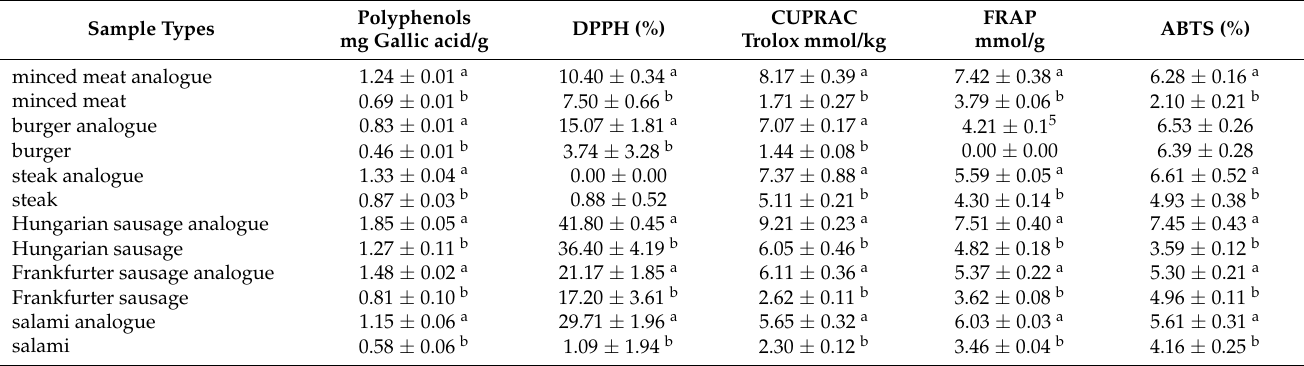
Table 2. Total polyphenol content and antioxidant capacity (DPPH, CUPRAC, FRAP,